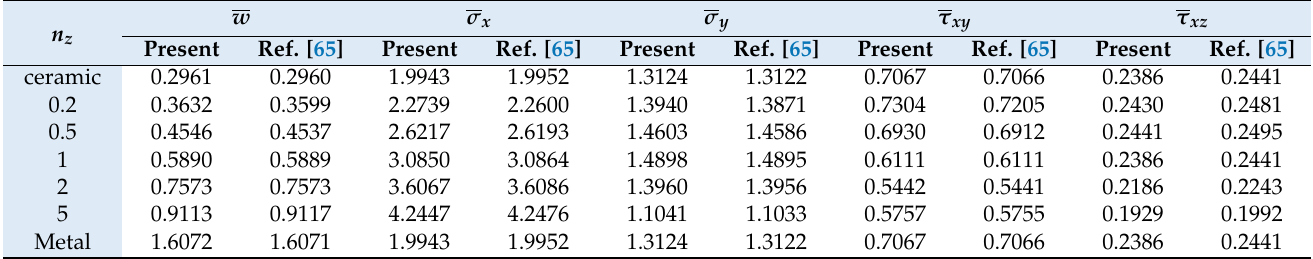
Table 3 demonstrates the influences of elastic foundation parameters on the maximum deflection, normal stress, and shear stress of BDFG simply supported plates. As shown,